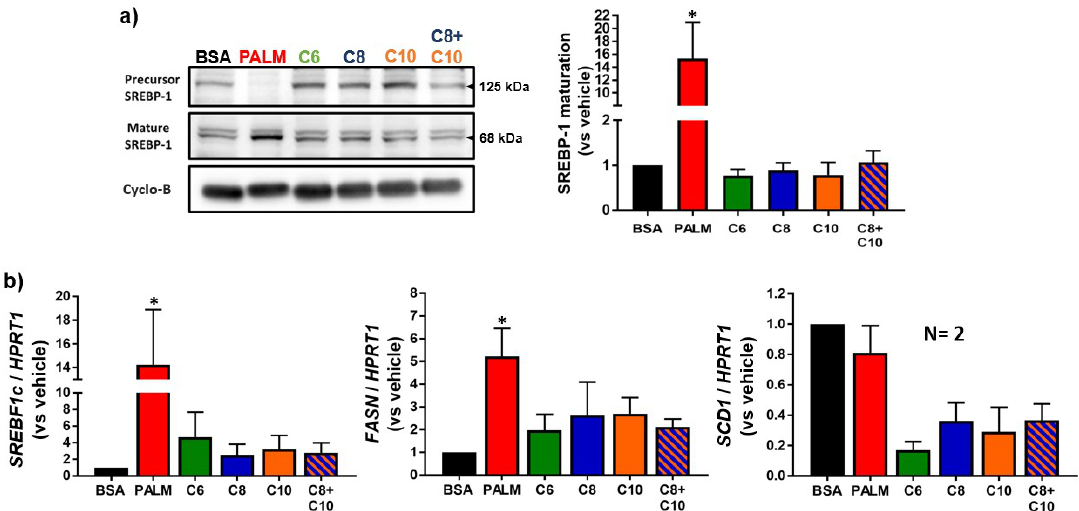
Figure 3. Effect of fatty acids on HepG2 lipid anabolism. HepG2 cells were treated 24 h with 0.25 mM PALM, C6, C8, C10, a C8 + C10 equimolar mix, or vehicle control (BSA). ( a ) Representative Western blots of precursor and mature (cleaved) SREBP-1 isoforms, as well as Cyclophilin-B loading control, and quantification of SREBP-1 maturation (mature/total ratio) relative to vehicle-treated control ( n = 3). ( b ) SREBF1c , FASN and SCD1 lipogenic marker mRNA expression relative to vehicle-treated control ( n = 3). * p -value < 0.05 versus BSA control.